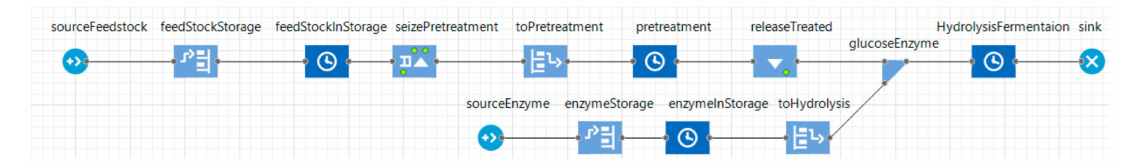
Figure 3. Fermentation and hydrolysis process in